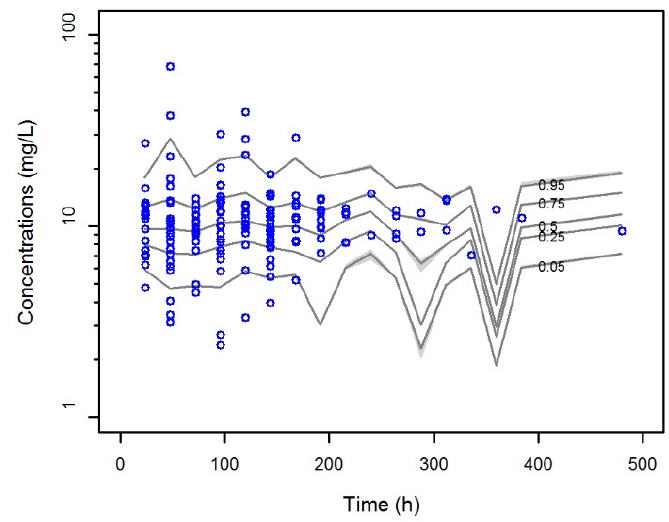
Figure 2. Visual predictive check (VPC) of meropenem concentration versus time for the final covariate model. Gray shadings display predicted interval of simulated data. Blue dots represent observed concentrations.